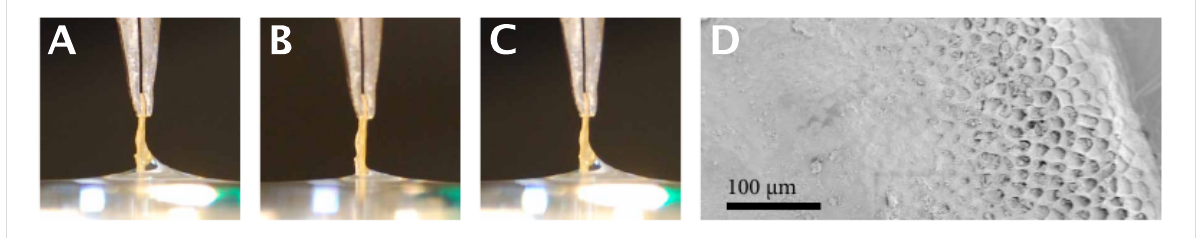
Figure 4: Scale of Phrynosoma cornutum dipped into deionised water. The freshly prepared scale (A) exhibits asymmetric behaviour. While on the inner side (left) a small meniscus, i.e., a large apparent contact angle of about 60° is formed, the outside of the scale (right) is wetted with an apparent contact angle of below 10°. If the experiment is repeated with a throughout dried scale (B), the difference of the inside and outside is less pronounced. After immersion of the scale in the water the scale again behaves like a freshly prepared scale (C). While the inside of this particular scale is completely flat (not shown), the outer surface exhibits a distinct micro ornamentation (D). Towards the edge (right) of the scale a honeycomb like structure is visible, while the centre of the scale is hardly structured.